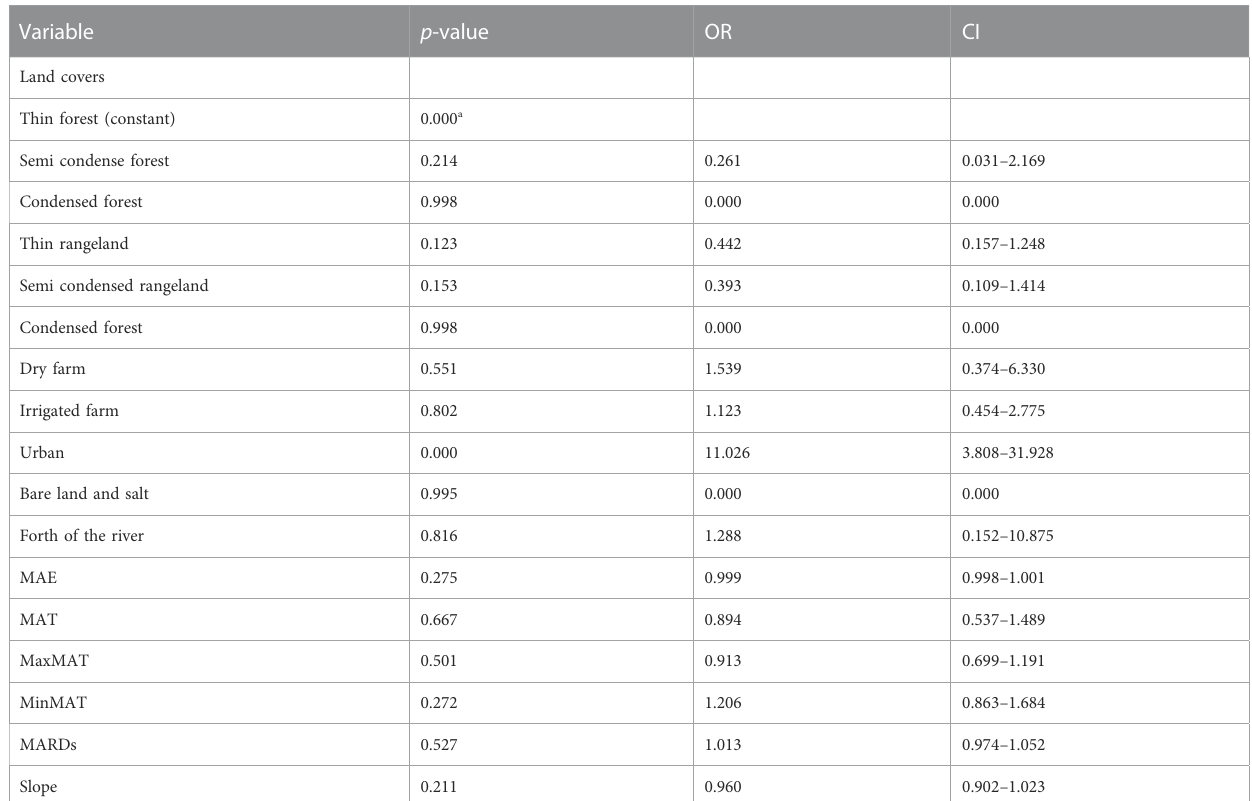
TABLE 3 Multivariate analysis of geo-climatic factors associated with asthma